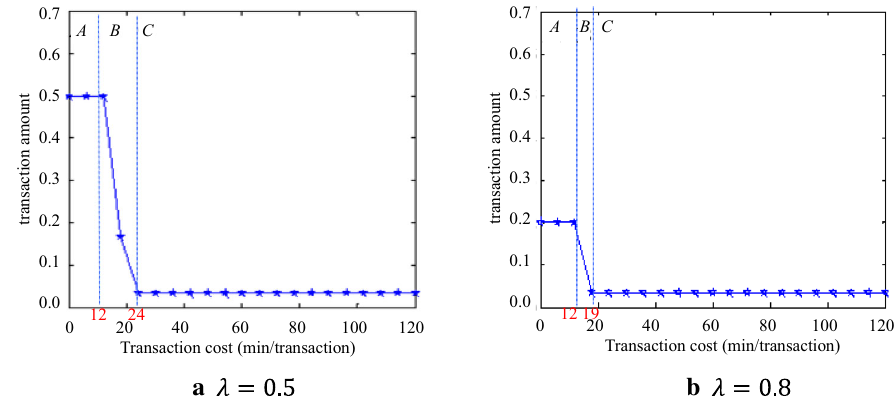
Fig. 3 Credit purchase changing with various T C . Note that zone A means that car users who buy credits buy the most credits, that is, x ¼ 1 (cid:5) k ; zone B means this car users will buy the credits but they will not choose to drive every day in a month, that is, x \ 1 (cid:5) k ; zone C means this car uses rarely buy